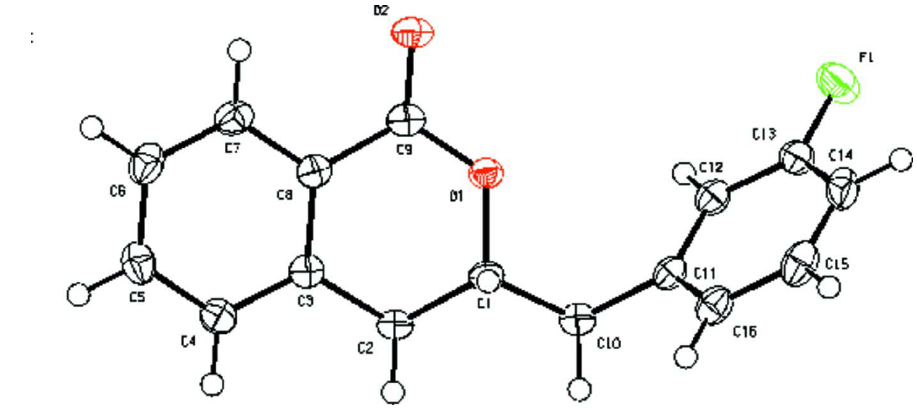
Figure 1 The molecular structure of the title molecule, with the atom-numbering scheme. Displacement ellipsoids are drawn at the 50% probability level.